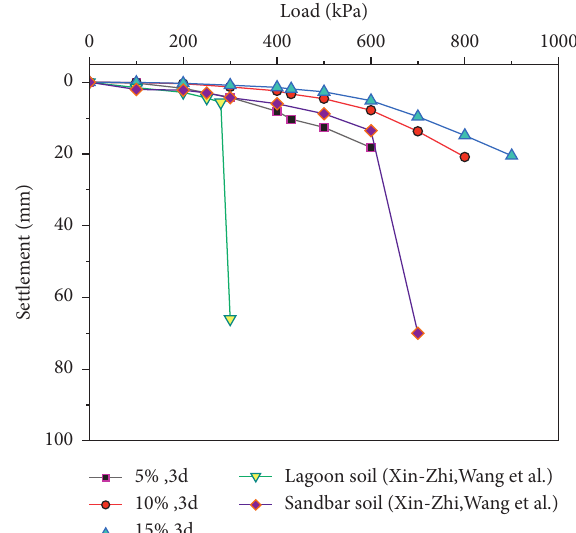
Figure 11: Comparison of bearing capacity of calcareous sand [4].